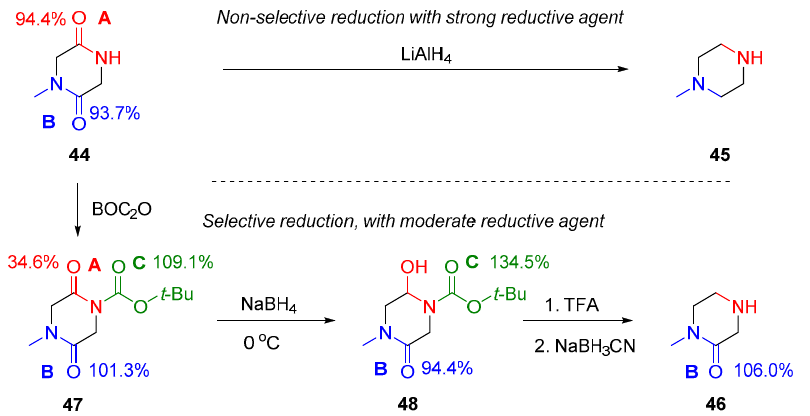
Figure 17. The non-selective and selective reduction of the amide bonds in a diketopiperazine derivative 44 , including amide-A and B, to yield 45 and 46 . The corresponding amidicity values were computed at B3LYP/6-31G(d,p) level of theory.